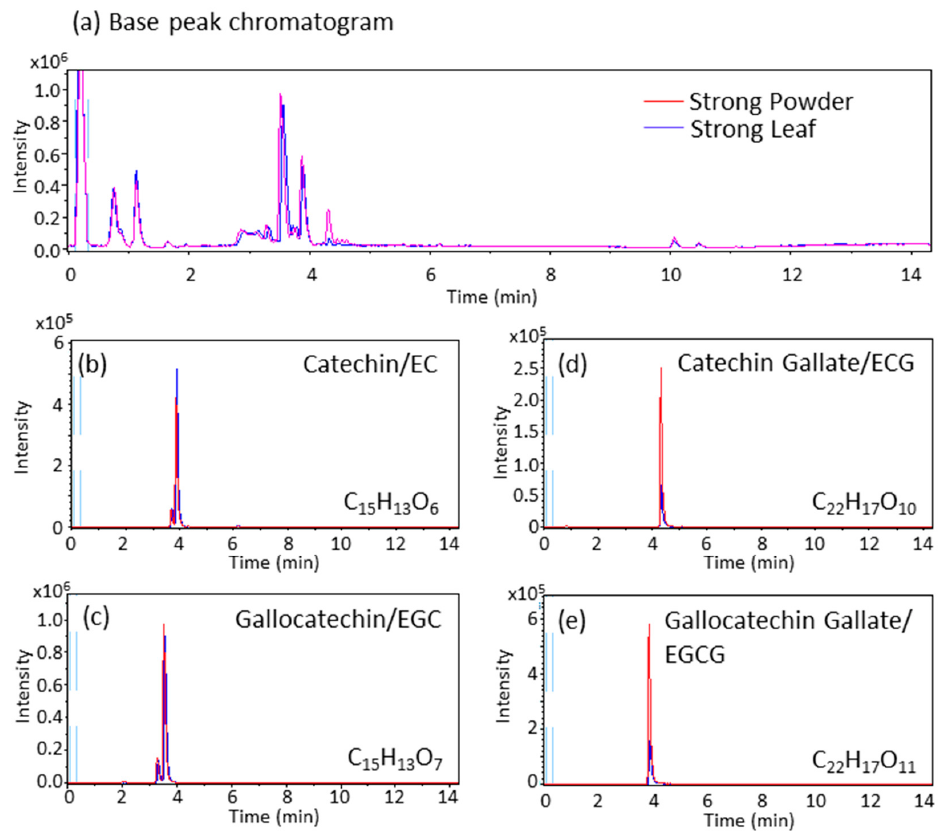
Figure 3. Differences of catechins between Powder and Leaf green tea in liquid chromatography–mass spectrometry (LC-MS) chromatogram (negative mode, representative data in three measurements): base peak chromatogram ( a ); and extracted ion chromatogram of indicated catechins (( b )–( e )). Table 2. Differences of catechin area between the Strong Powder tea and Strong Leaf tea measured by liquid chromatography–tandem mass spectrometry (LC-MS/MS) analysis.